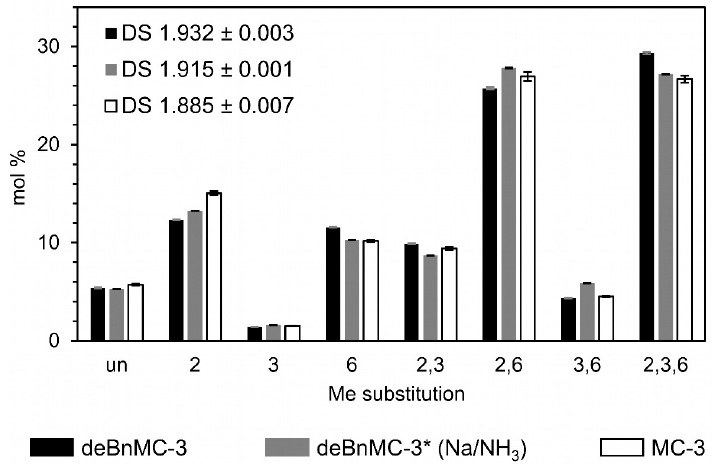
Figure 10. Methyl substitution patterns of deBnMC-3 (Method-2c, Table 1), deBnMC-3* (Na/NH 3 , Method-3, Table 1), and MC-3 (for comparison), evaluated based on the monomer analysis of alditol acetates by GLC-FID. For details refer to the Materials and Methods Section 2.6.1.